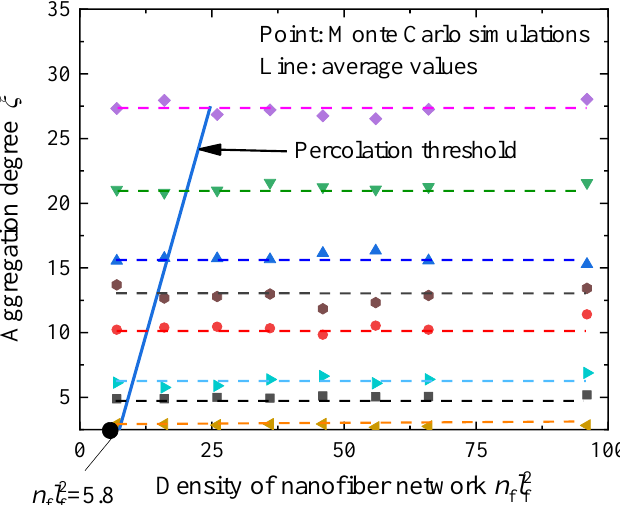
Figure A4. The aggregation degrees of the nanofiber network at different densities.